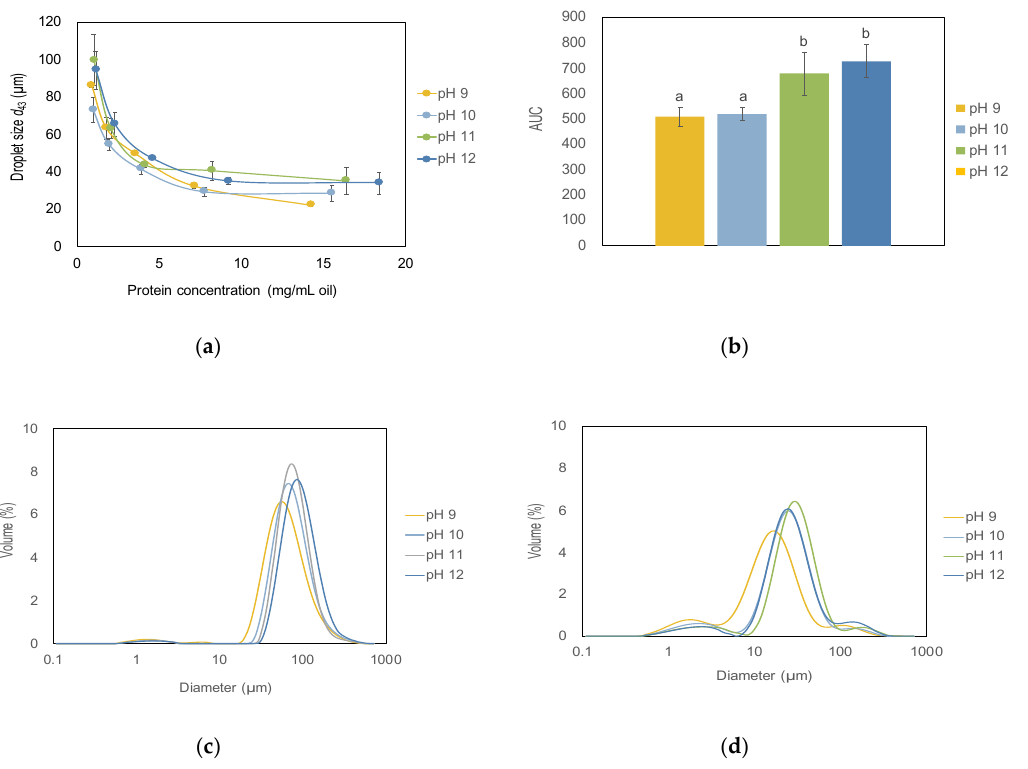
Figure 4. ( a ) Emulsion droplet size (d 43 ) as a function of protein concentration in emulsions stabilized by rapeseed protein extracted at different pHs. Emulsions were 30% oil-in-water emulsions produced by high shear homogenization. ( b ) Area under the curve for droplet size d 43. Different letters indicate significant differences, p < 0.05. ( c ) Size distributions of emulsions stabilized by rapeseed protein extracted at different alkali pH values. Protein concentrations in the emulsions were 0.9–1.1 mg/mL oil. ( d ) Size distributions of emulsions stabilized by rapeseed protein extracted at different alkali pH values. Protein concentrations in the emulsions were 14–18 mg/mL oil. Data is an average from six measurements of two extractions at each pH value.